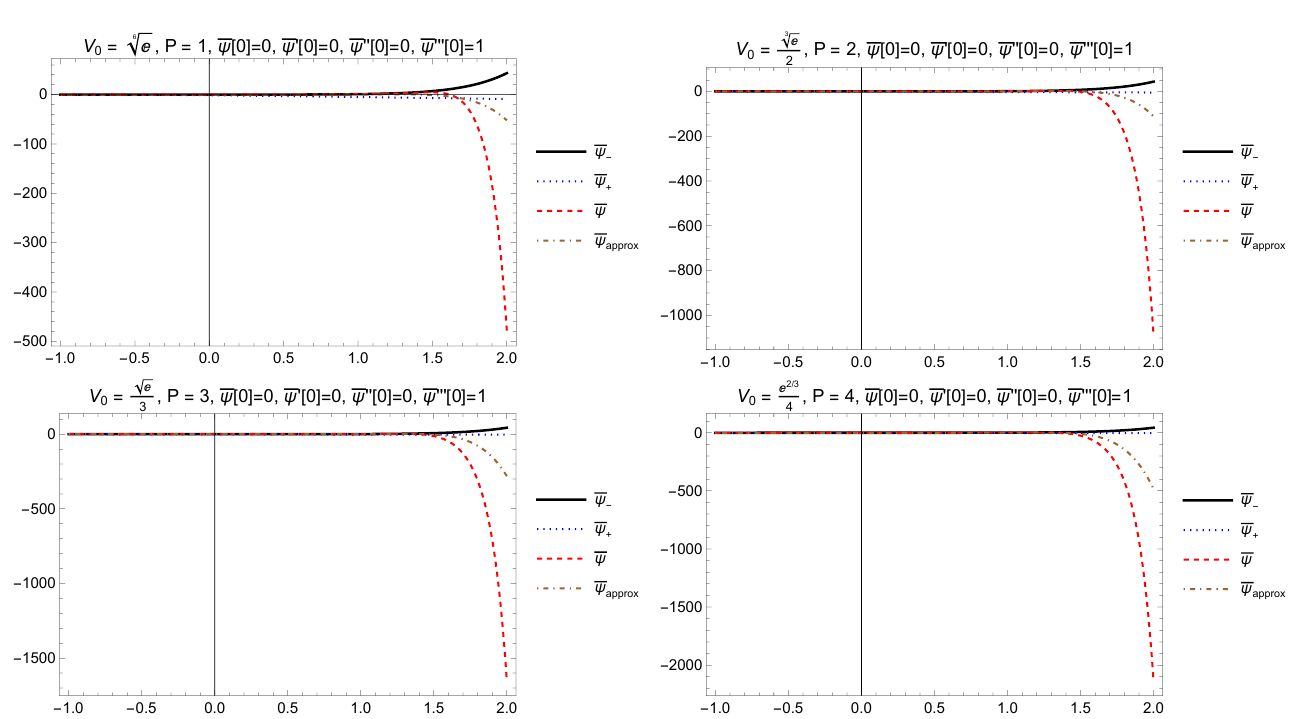
Figure 3. Comparison of exact solution ¯ ψ of (39) with initial conditions ¯ ψ ( 0 ) = 0, ¯ ψ (cid:48) ( 0 ) =